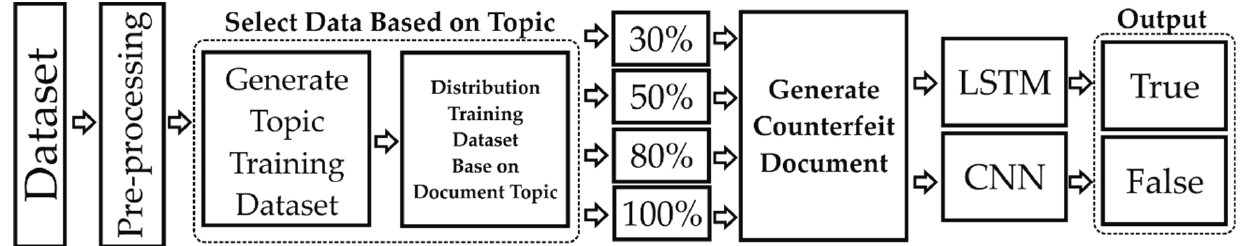
Figure 1. Overall Process of TB-BCG.